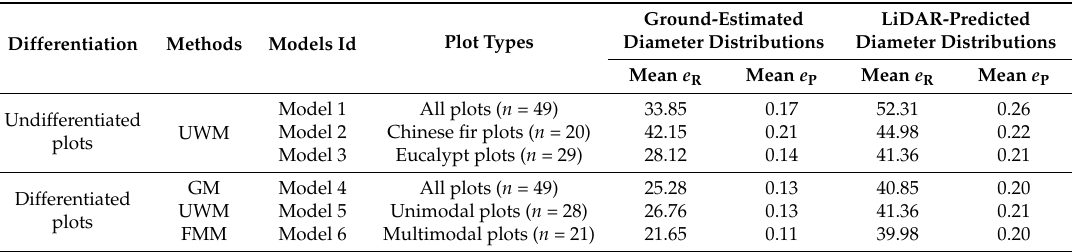
Ground-Estimated Diameter